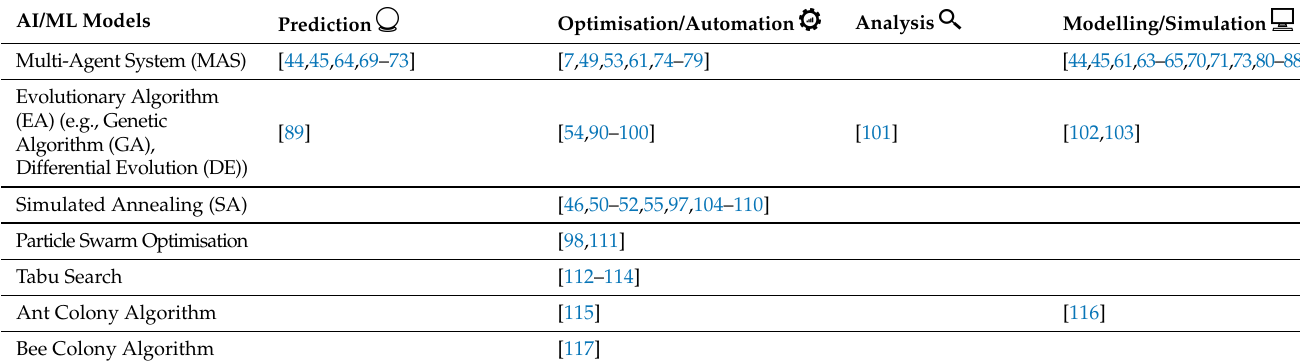
Table 5. Publication distribution with the design